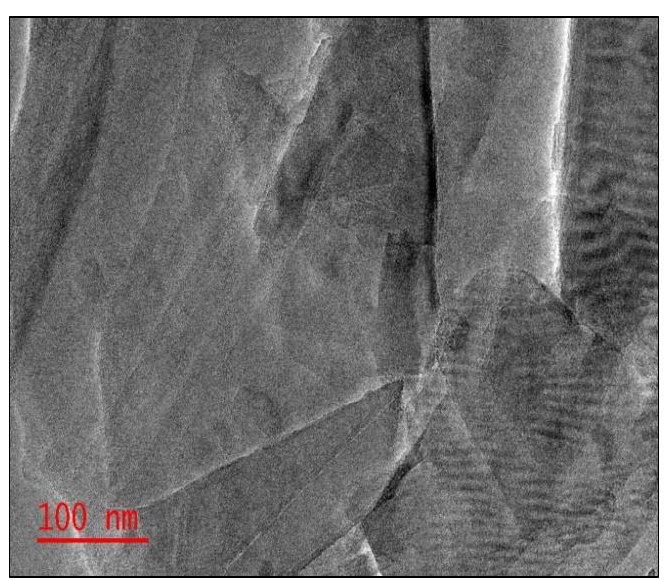
Figure 2: TEM of Graphite nanoparticles.